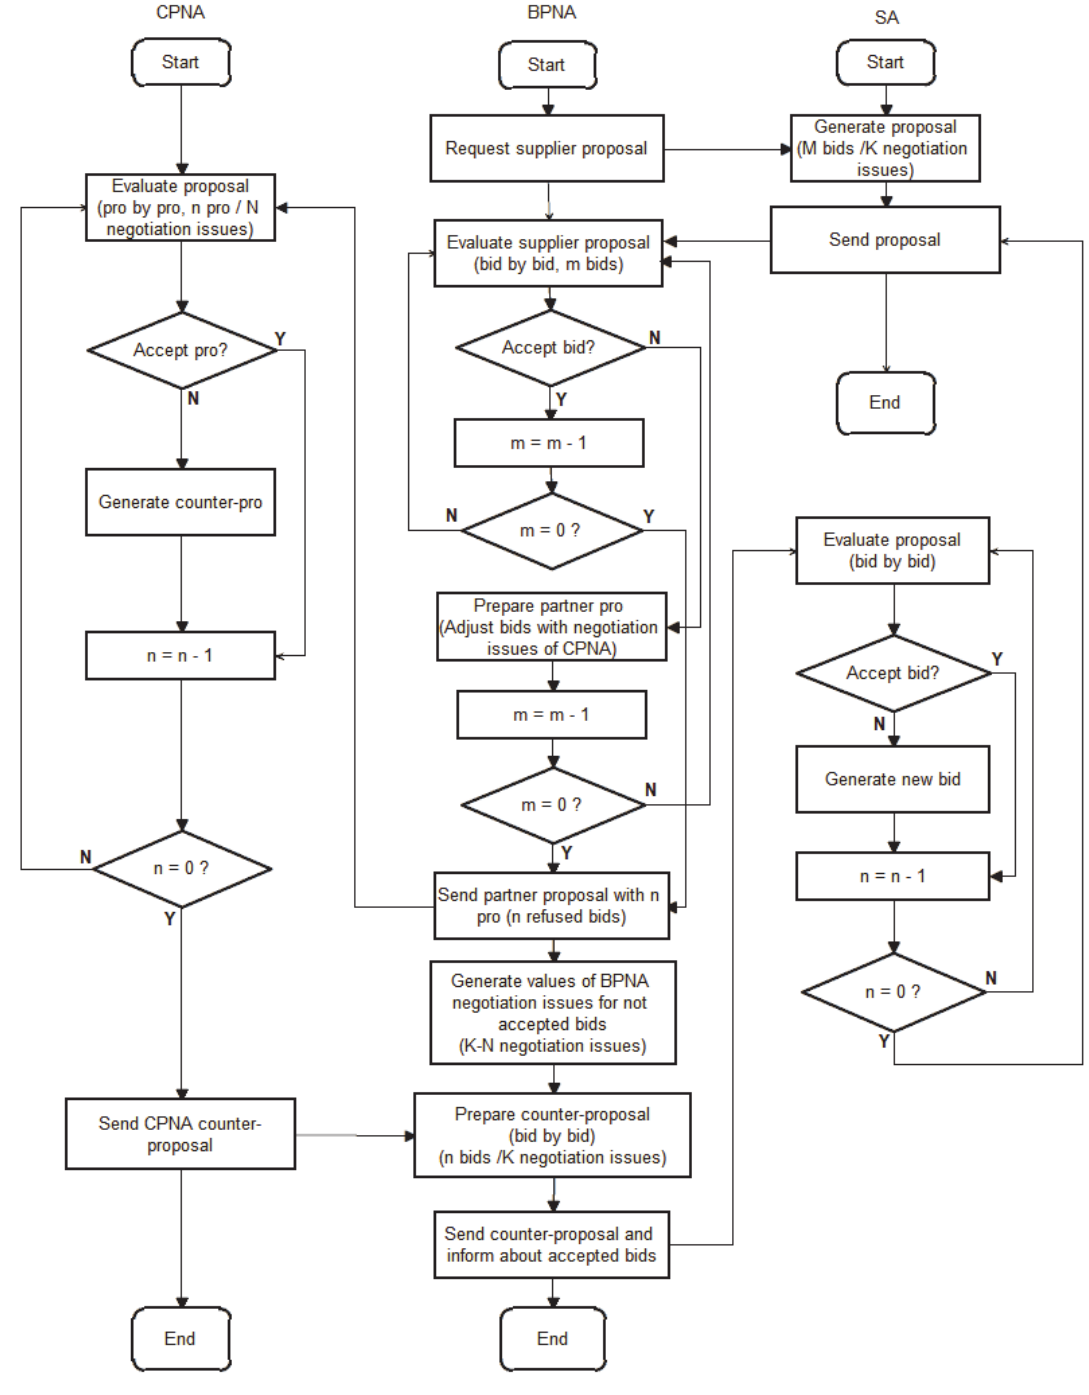
Fig. 11. Bilateral bargaining between a CPNA, a BPNA and a